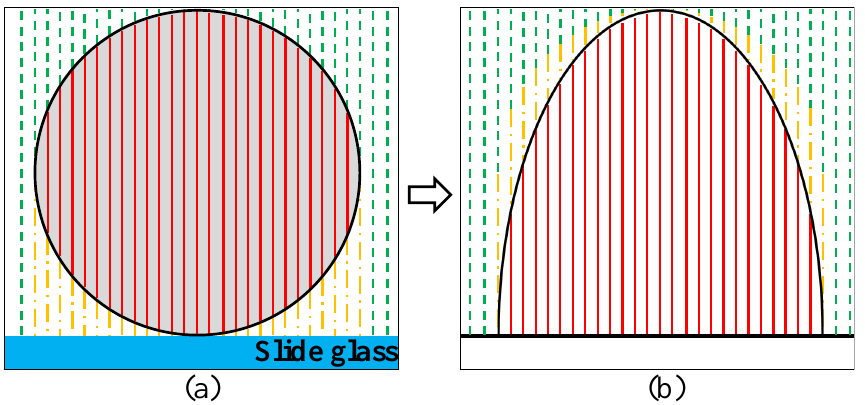
Figure 2. Difference between ( a ) real object (Microsphere) depth information and ( b ) depth profile by